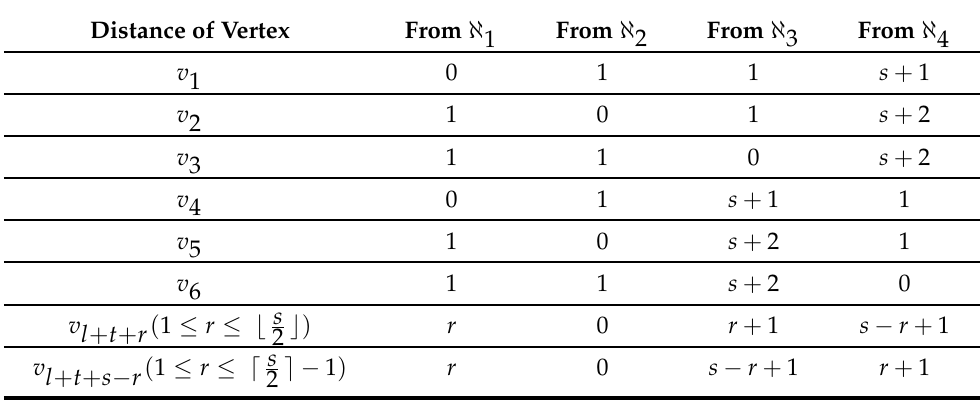
Table 2. Distance codes of V ( KP ( l , t , s )) with respect to ℵ for l = 3 and t = 3. Distance of Vertex From ℵ